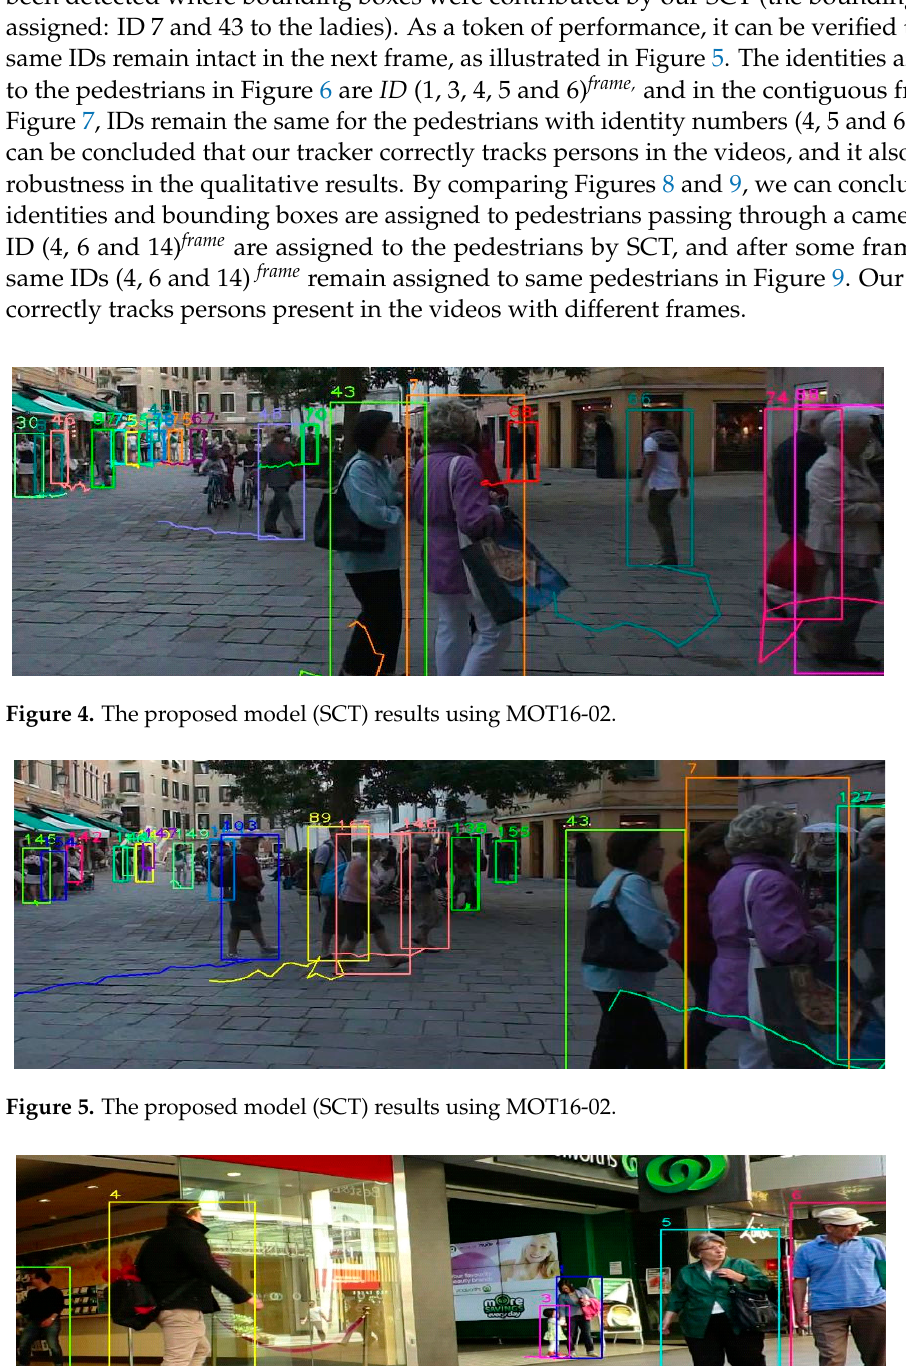
Figure 6. The proposed model (SCT) results using MOT 16-09.